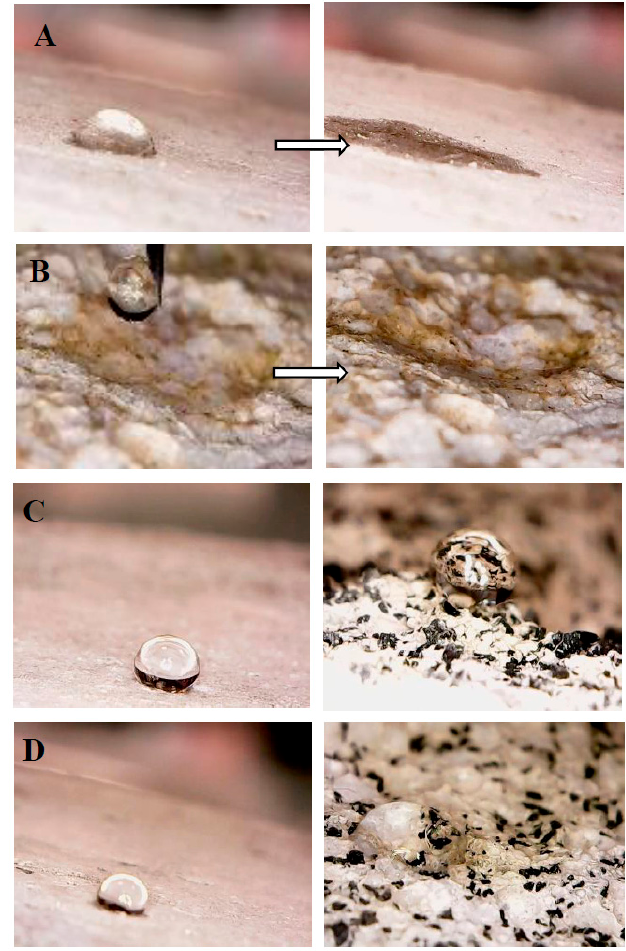
Figure 10. Wettability tests on the side surface of ( A ) Norm (sample 1) at t = 0 s (left) and at t = 60 s (right), on the fracture surface of ( B ) PG (sample 5) at t = 0 s (left) and at t = 2 s (right), on the side (left) and fracture (right) surface of ( C ) TR f (sample 3) at t = 150 s, on the side (left) and fracture (right) surface of ( D ) TR f /PG (sample 8) at t = 150 s.